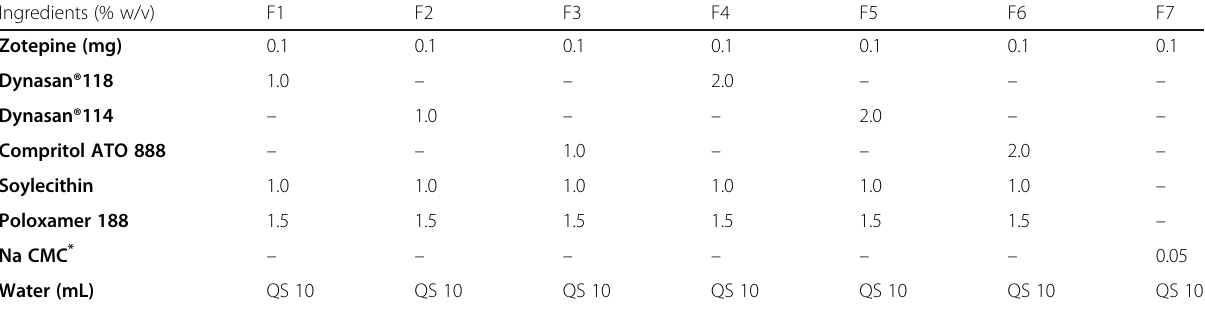
Table 1 Composition of zotepine loaded solid lipid nanoparticles Ingredients (% w/v) F1 F2 F3 Zotepine (mg)